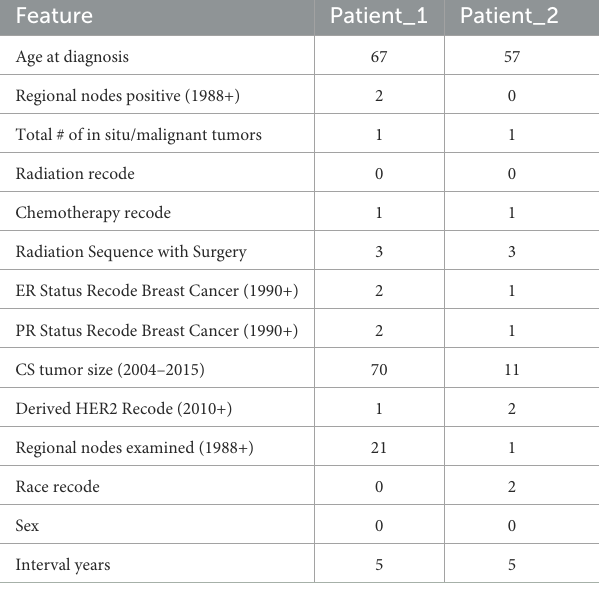
TABLE 7 Sample data for two